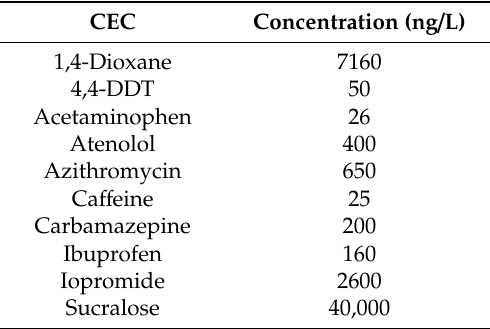
Table 22. Some of the existing contaminants of emerging concern (CECs) in recycled water reported by literature [174].